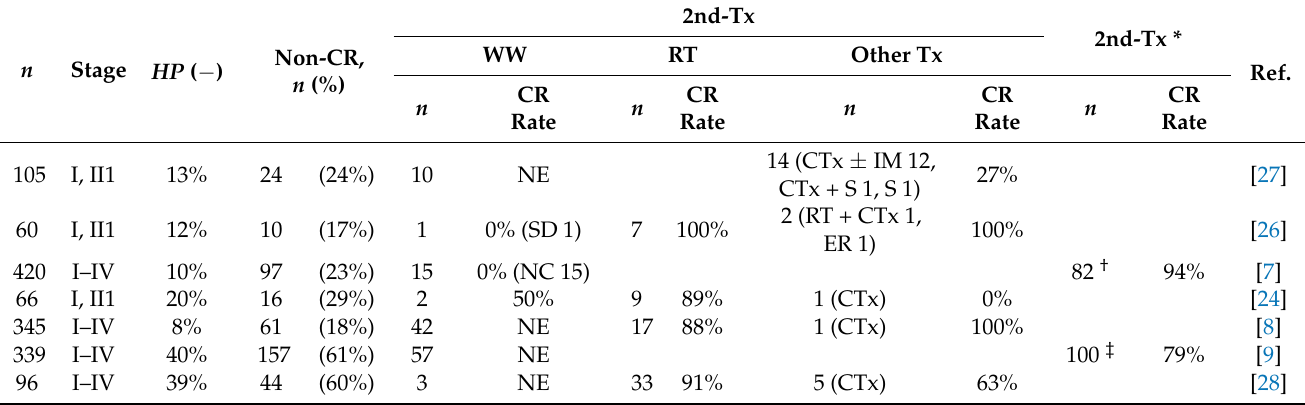
Table 2. Second-line treatment in non-responders to eradication therapy in gastric MALT